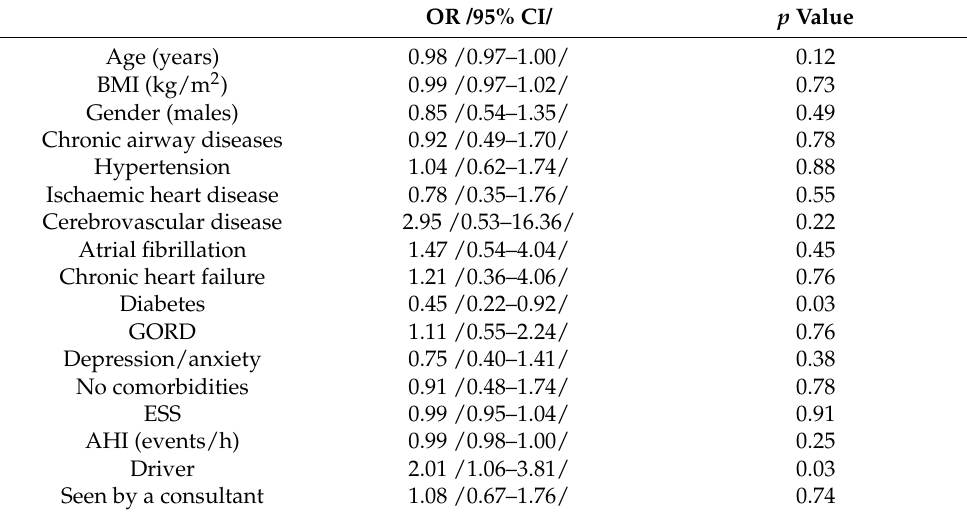
Table 3. Factors associated with compliance at 90 days.